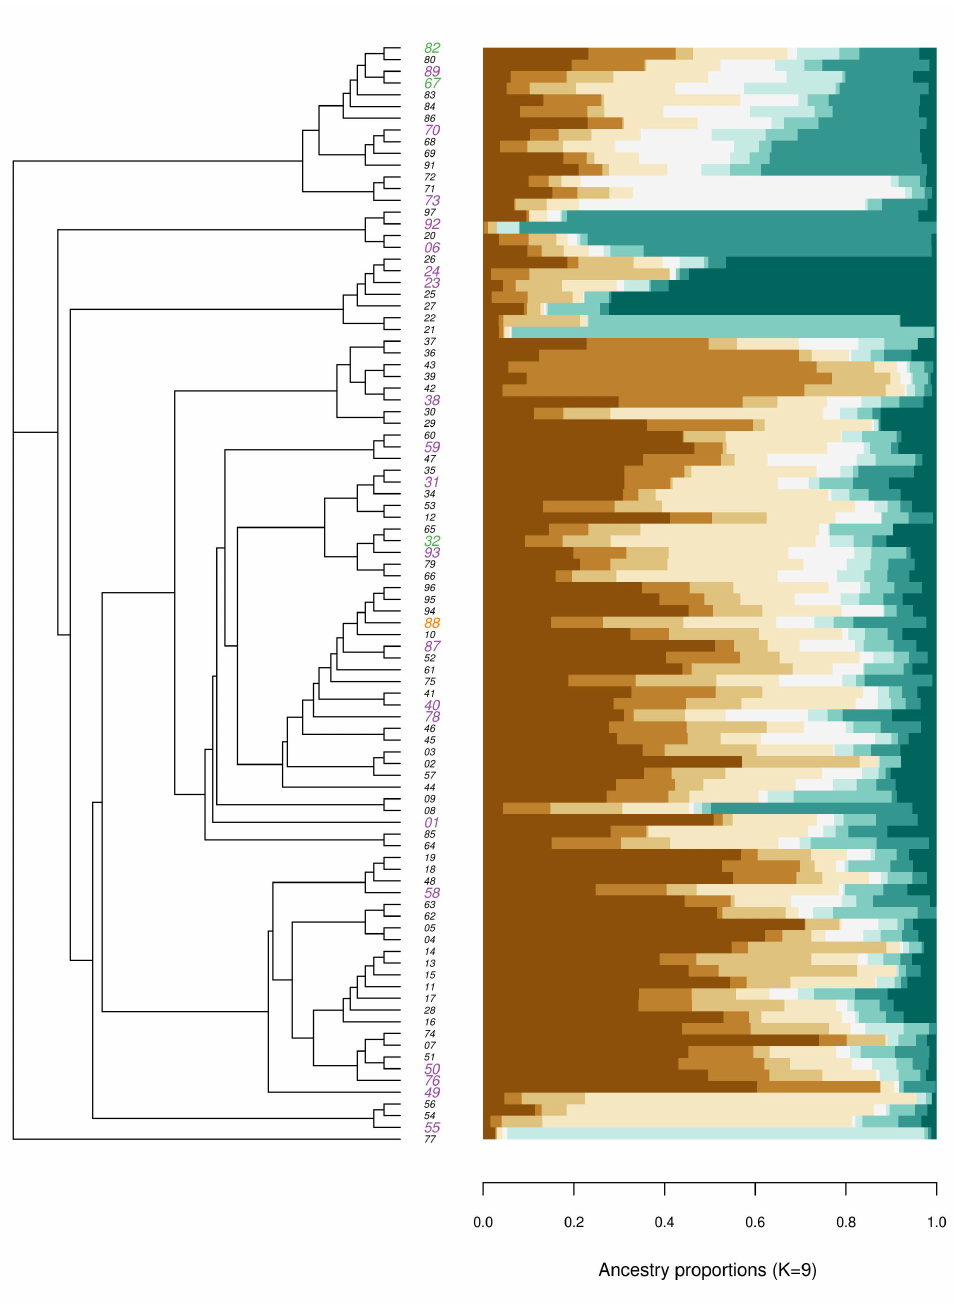
Figure 4. Phylogenetic tree and ancestry matrix (based on K = 9) of 94 genotypes (comprising 741 individuals) genotyped in the 2018 trial based on 1190 SNPs. Highlighted (enlarged and colorized labels) genotypes showed a better value for the trait Total_NoB (total number of beans) compared to the reference genotype Bonela (88, in orange) either in the year 2018 or 2020 (purple). Genotypes 32, 67 and 82 that were better than Bonela in both years are marked in green. The genotype 77 of Chinese origin was defined as outgroup and is located at the bottom of the phylogenetic